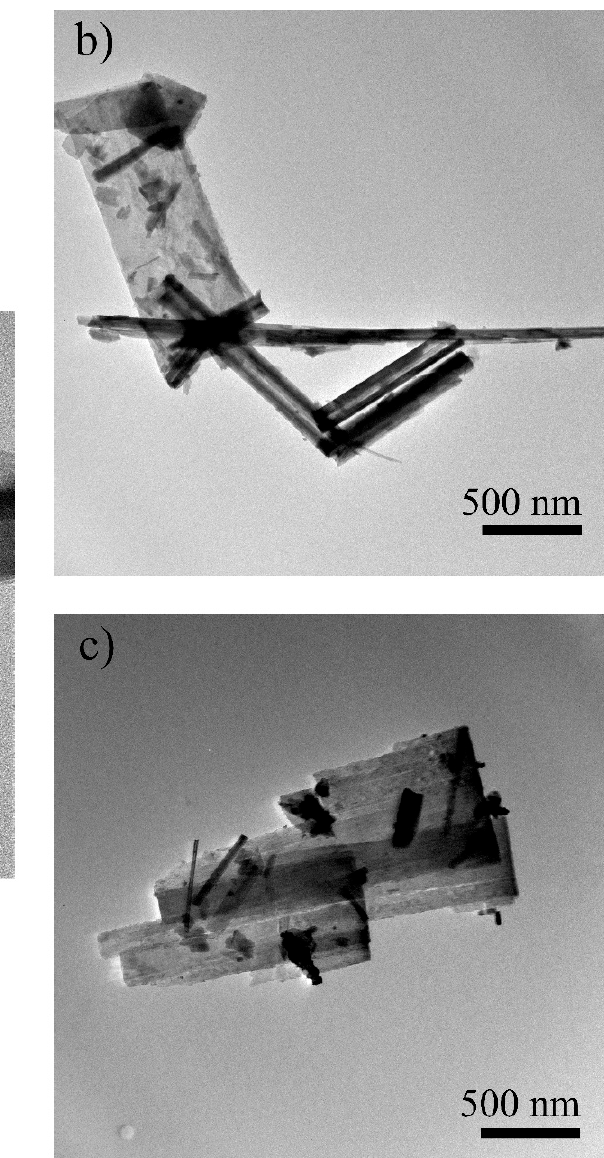
Figure 8. TEM images of 180 synthetized products: ( a ) nanobelts, ( b ) and ( c ) a mixture of nanobelts/plate ‐ like particles.